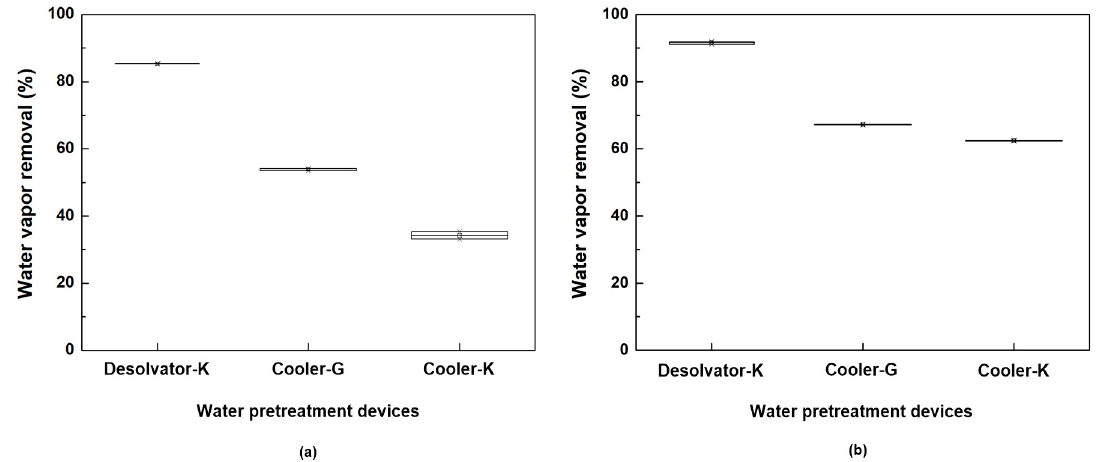
Figure 2. Water vapor removal of water pretreatment devices; ( a ) 50% RH; ( b ) 90% RH.